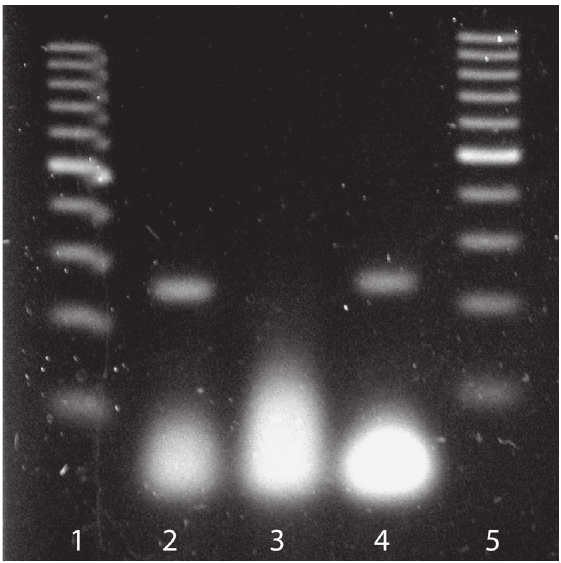
Figure 5 - Photography of agarose gel displaying banding of the samples submitted to PCR. Channels 1 and 5 have standard marker of 100 base pairs. Channel 2 with PCR product of cells in culture (positive control). Channel 3 with PCR product of the bone tissue sample of animal gfp - (negative control). Channel 4 with PCR product of the paraffinized bone tissue sample of one animal treated with MSC/ gfp +